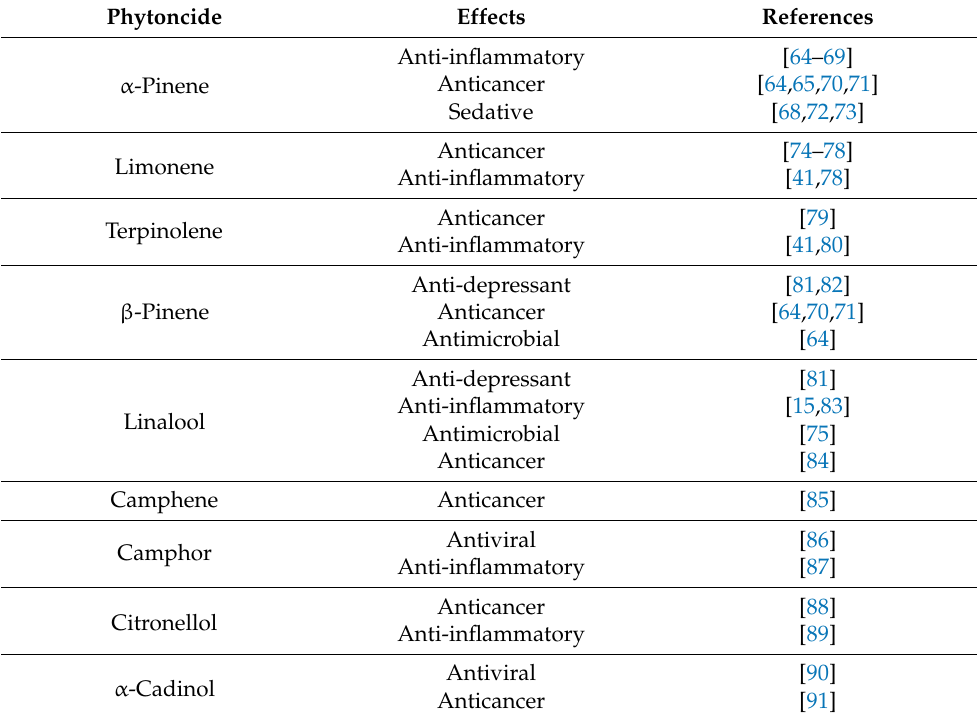
Table 3. Literature evidence relative to biological activities of BVOCs detected in the investigated